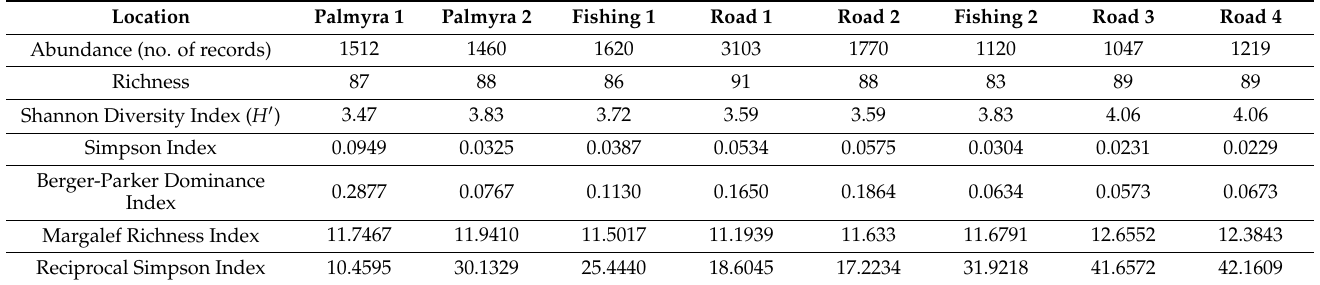
Table 2. Diversity indices in the different sampling stations in the proposed Sarasalai mangrove